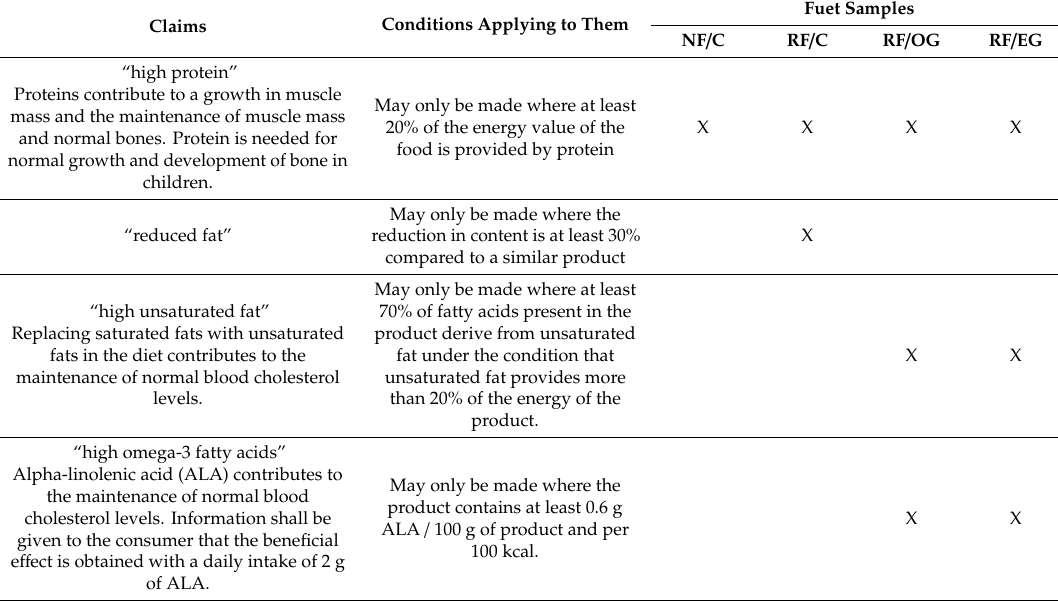
Table 3. Nutrition and health claims authorised in fuets according to Regulation (EC) No 1924 / 2006 and Commission Regulation No 432 /